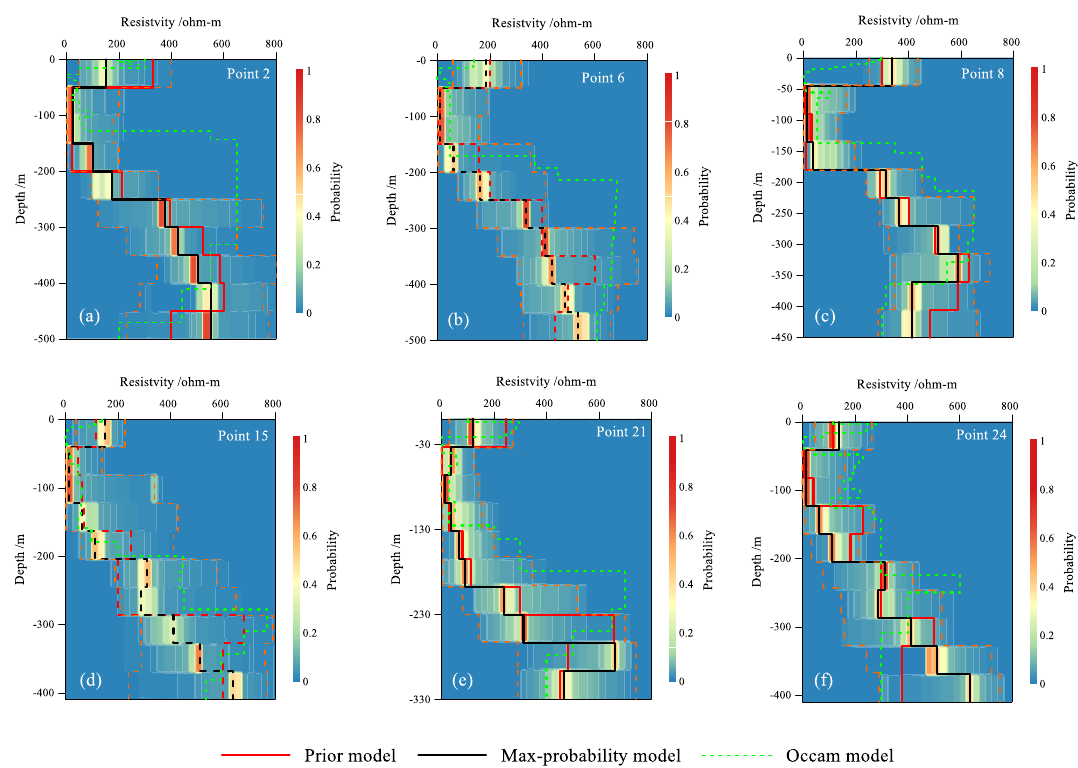
fidence boundary of the posterior distribution in each layer. It also shows the prior models (red lines) based on the local survey report [39] and the maximum probability models (black